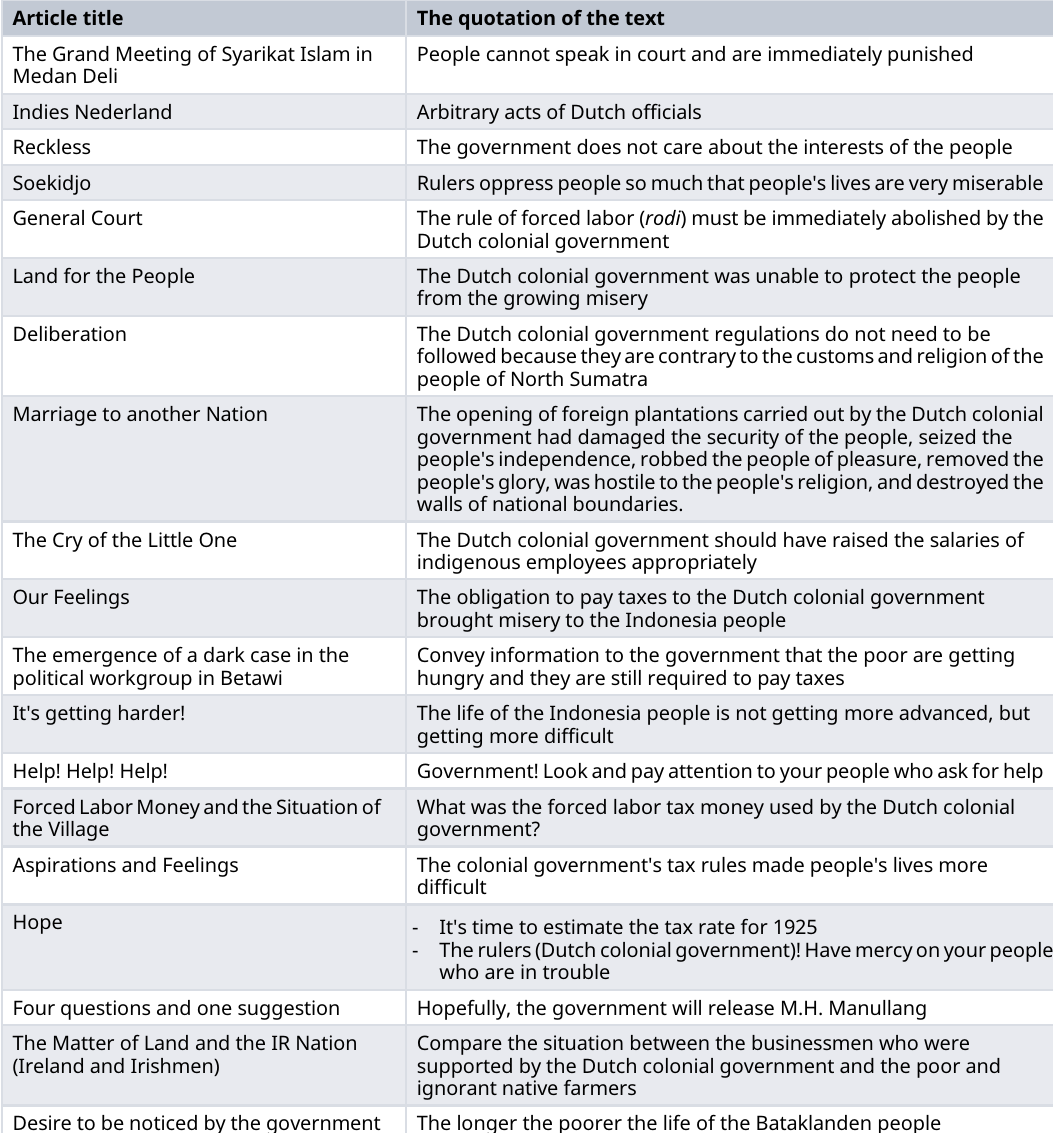
Table 7. The microstructural analysis results from the newspapers that criticizing the colonial government's policies. Article title The quotation of the